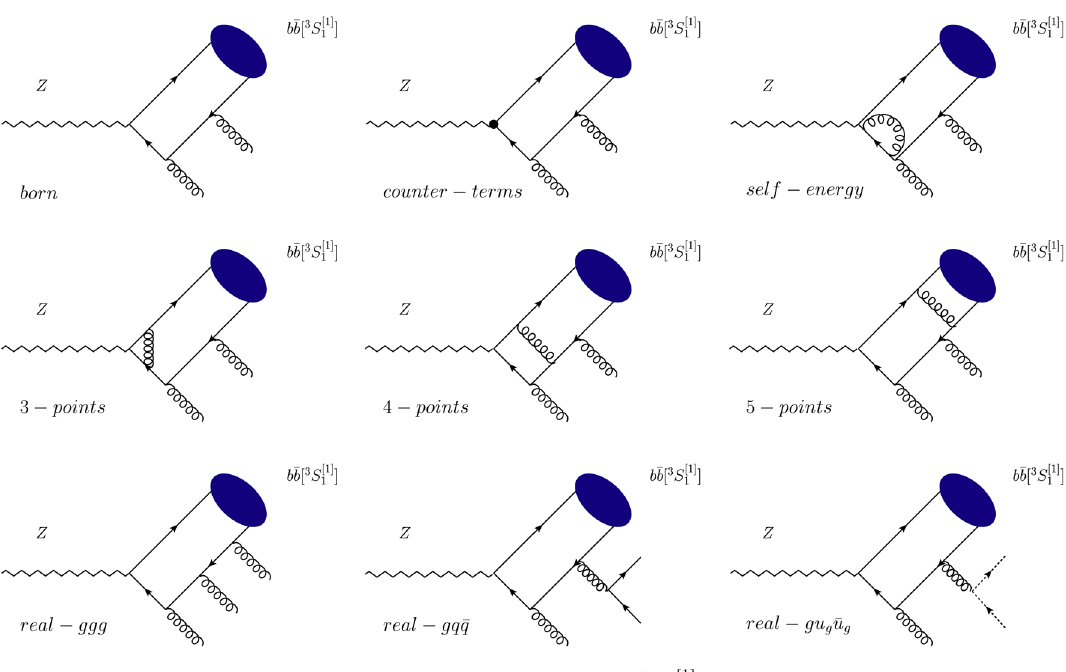
Fig. 1 Representative Feynman diagrams for the NLO QCD corrections to Z → b ¯ b [ 3 S [ 1 ] light quarks ( u , d , s ) and the ghost particles, respectively